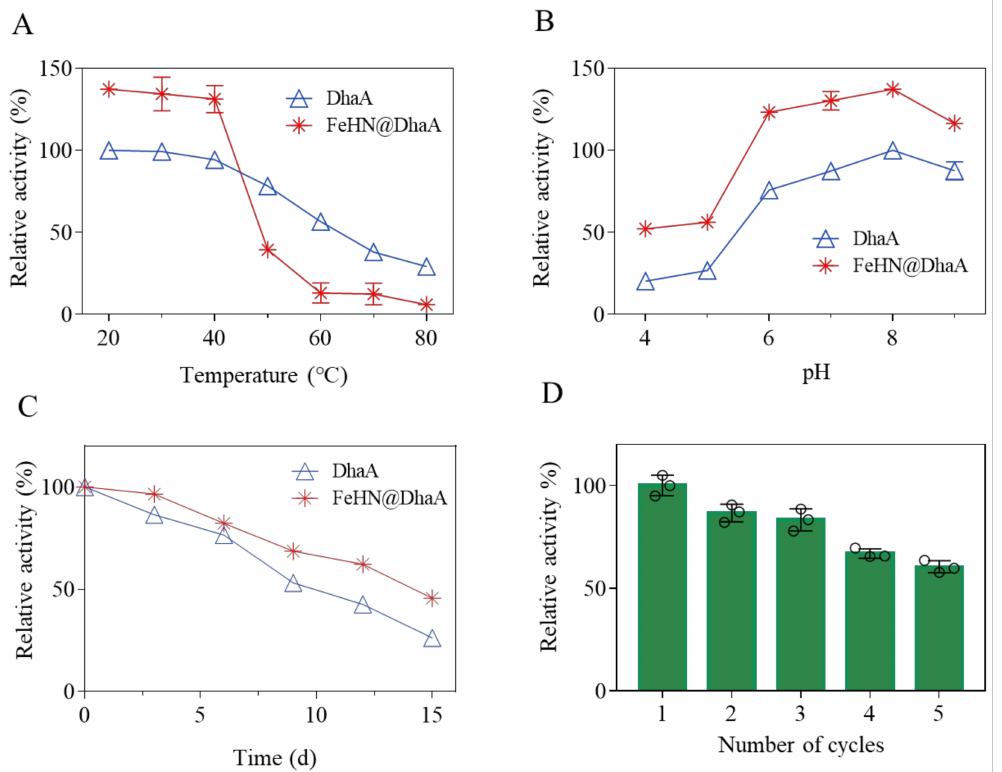
Figure 7. Thermal ( A ), pH ( B ) and long-term storage ( C ) stability of free and immobilized DhaA. Reusability of immobilized DhaA ( D